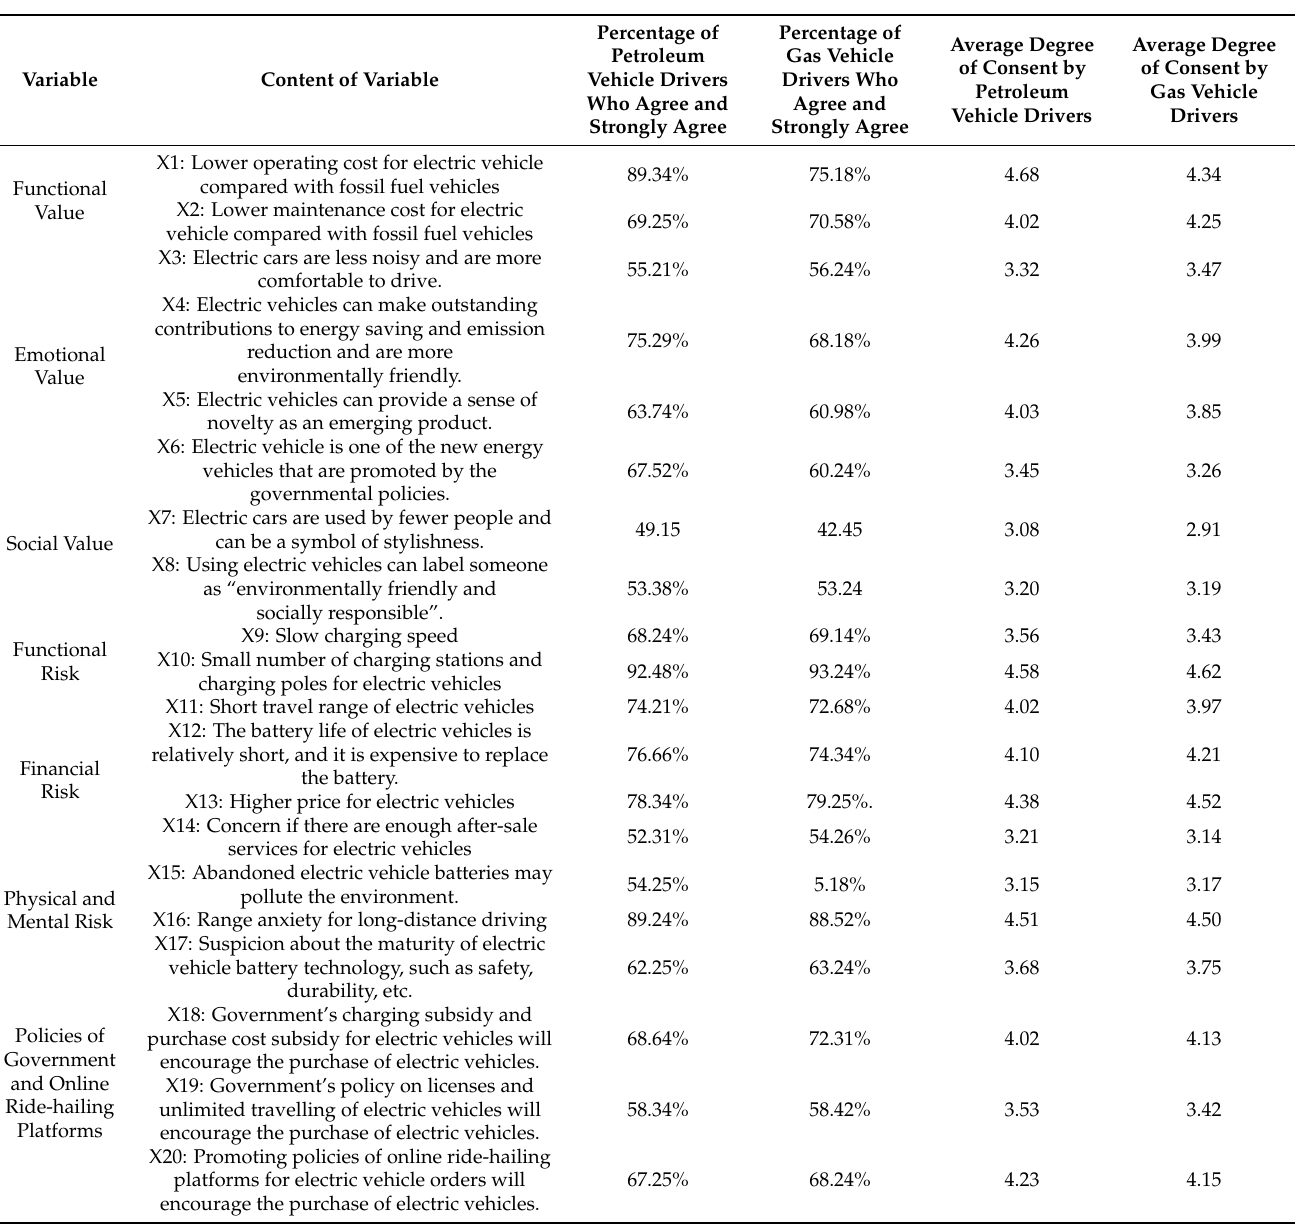
Table 7. Perceived value for Didi drivers of electric